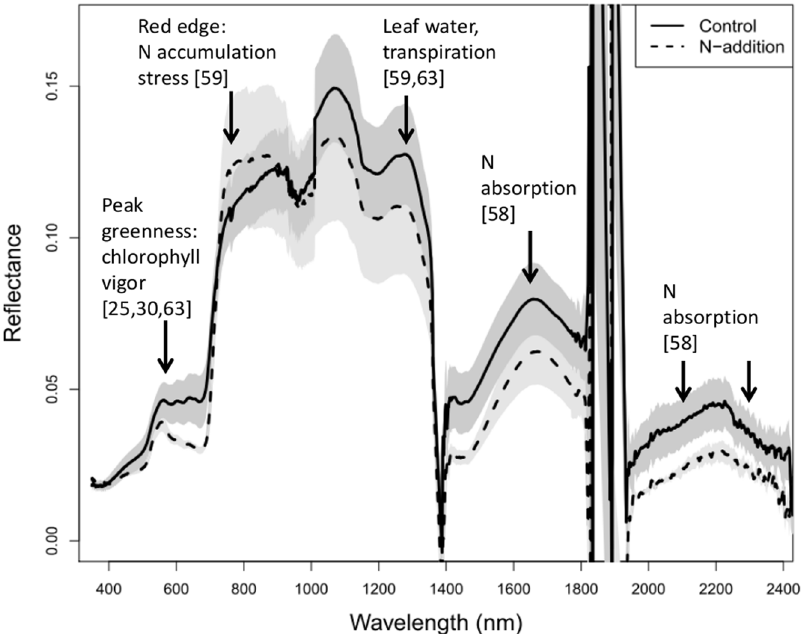
Figure 2. Reflectance spectra for treatments. Averaged reflectance spectrum for N-addition and control plants (N=4 each). The shaded grey areas represent 6 one standard error. Spectra associated with foliar N in the literature are indicated, with corresponding citations in brackets.